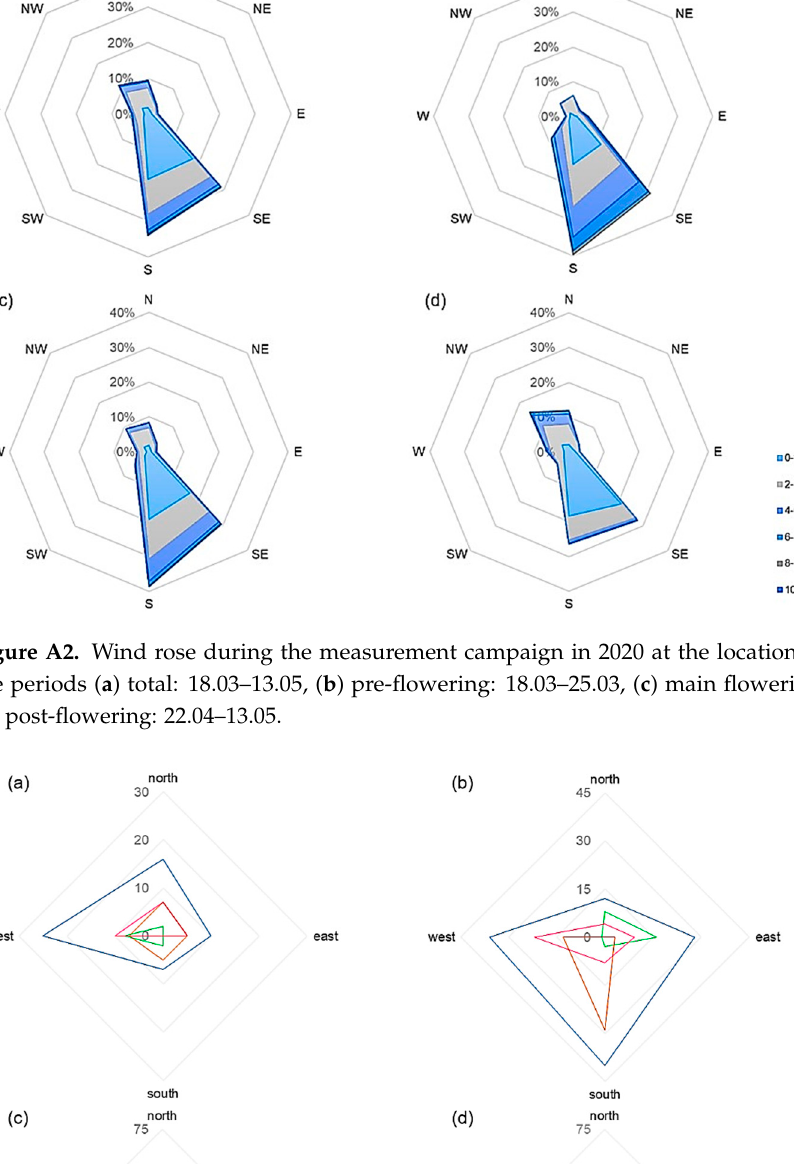
Figure A1. Wind rose during the measurement campaign in 2019 at the location Schorndorf for the periods ( a ) total: 18.03–14.05, ( b ) pre-flowering: 18.03–02.04, ( c ) main flowering: 02.04–23.04, ( d ) post-flowering: 23.04–14.05.